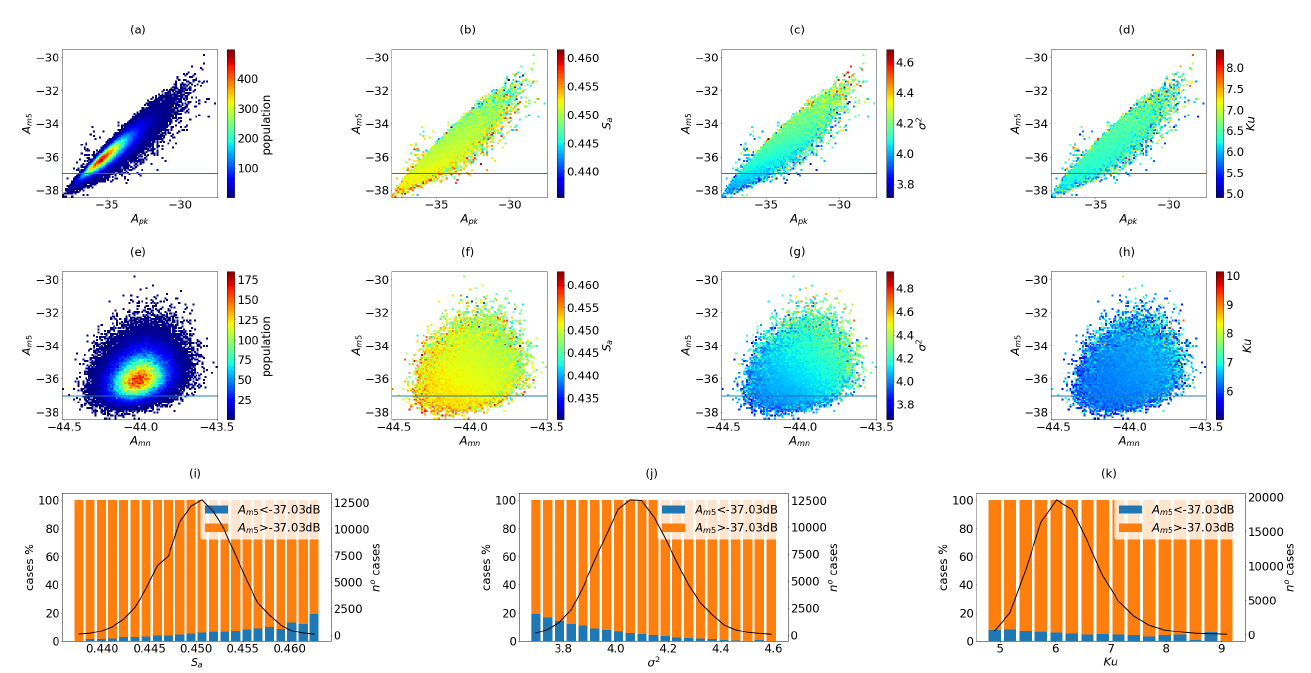
Figure 5. Results of 100,000 random cases of configuration 100I. In the first row, the apertures are presented in a A m 5 vs. A pk map, ( a ) population, ( b ) S a , ( c ) σ 2 and ( d ) Ku . In the second row, the apertures are presented in A m 5 vs. A mn map, ( e ) population, ( f ) S a , ( g ) σ 2 and ( h ) ku . In the third row, the distribution of cases against the coarray parameters are presented, marking the proportion of cases that fulfill the TH A threshold, ( i ) S a , ( j ) σ 2 and ( k ) Ku . m 5